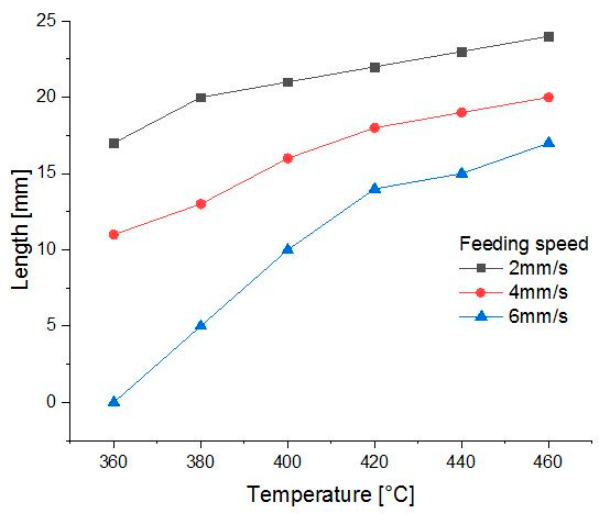
Figure 3. Length of the liquid column in the nozzle with diameter of 0.8 mm using the data from Wang et al. [29].